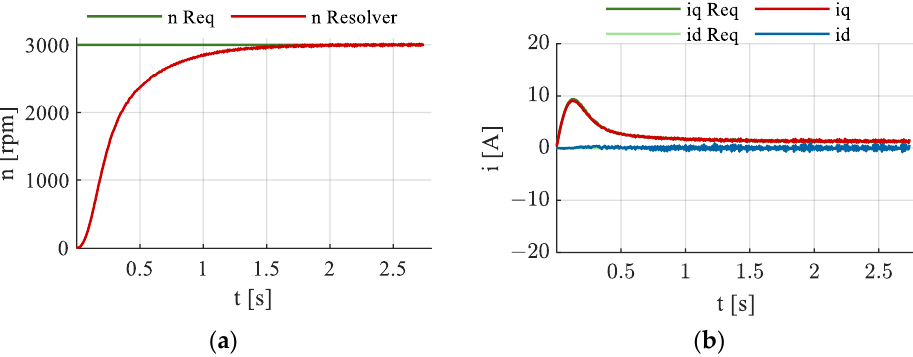
Figure 6. Current in transformed subsystems during the startup transient of the six-phase operation: ( a ) α–β subsystems; ( b ) z1 – z2 subsystem.